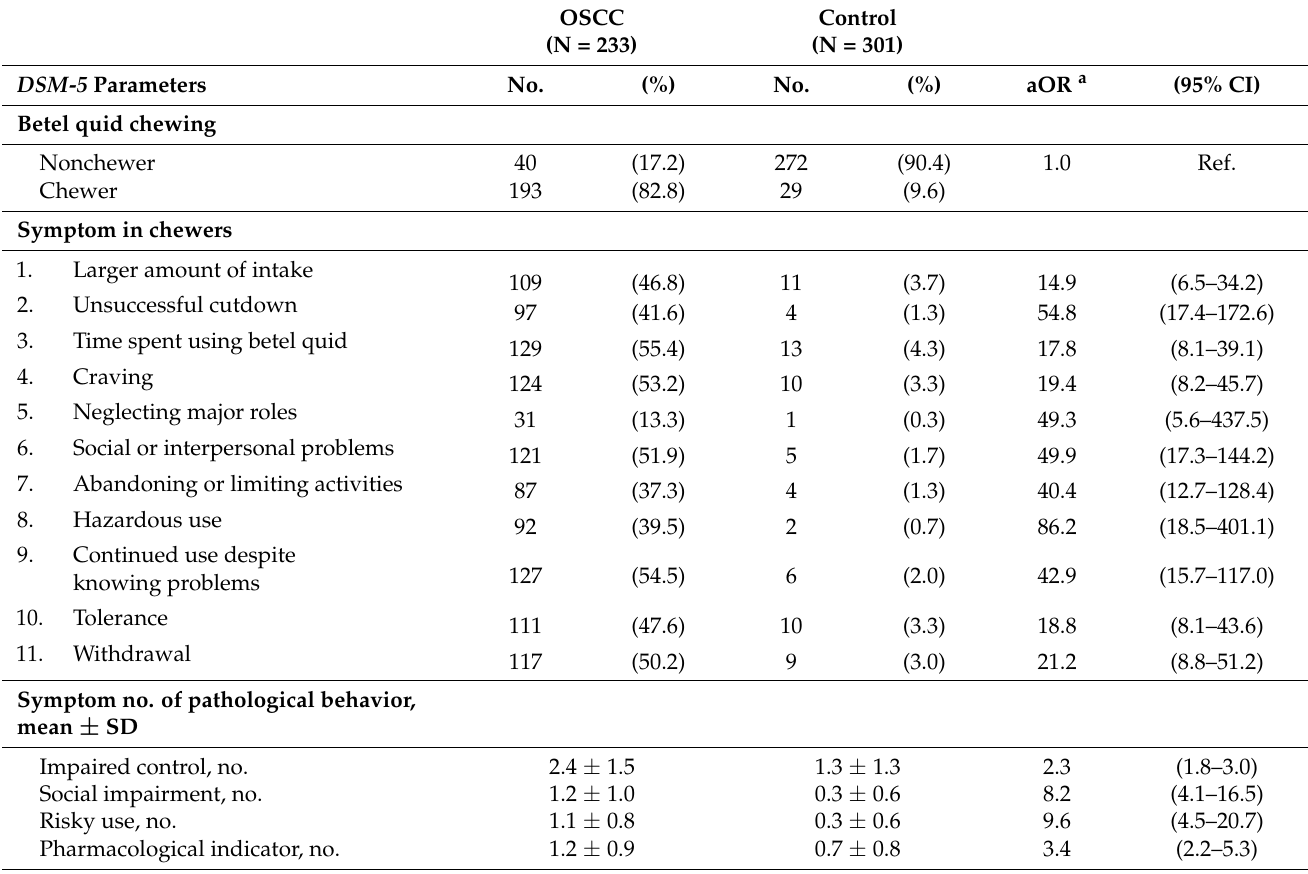
Table 4. Adjusted odds ratios of oral squamous cell carcinoma associated with DSM-5 symptoms, pathological behavior, and use disorder of betel